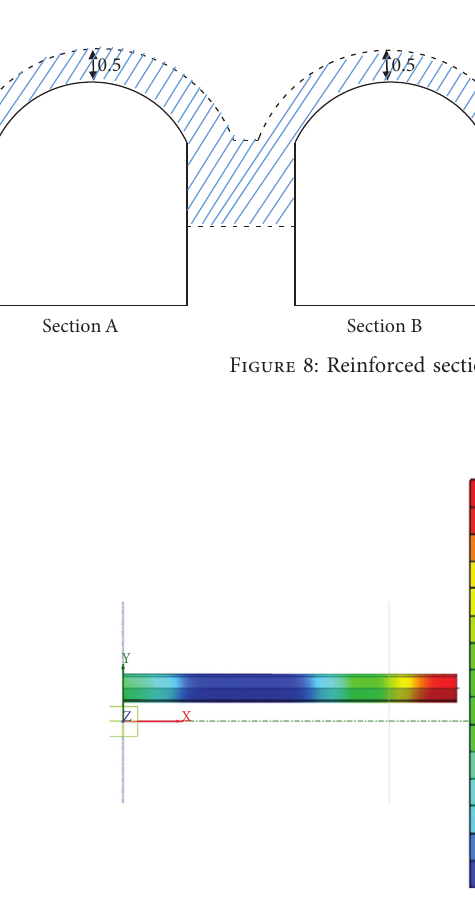
Figure 9: Pipeline deformation cloud map.